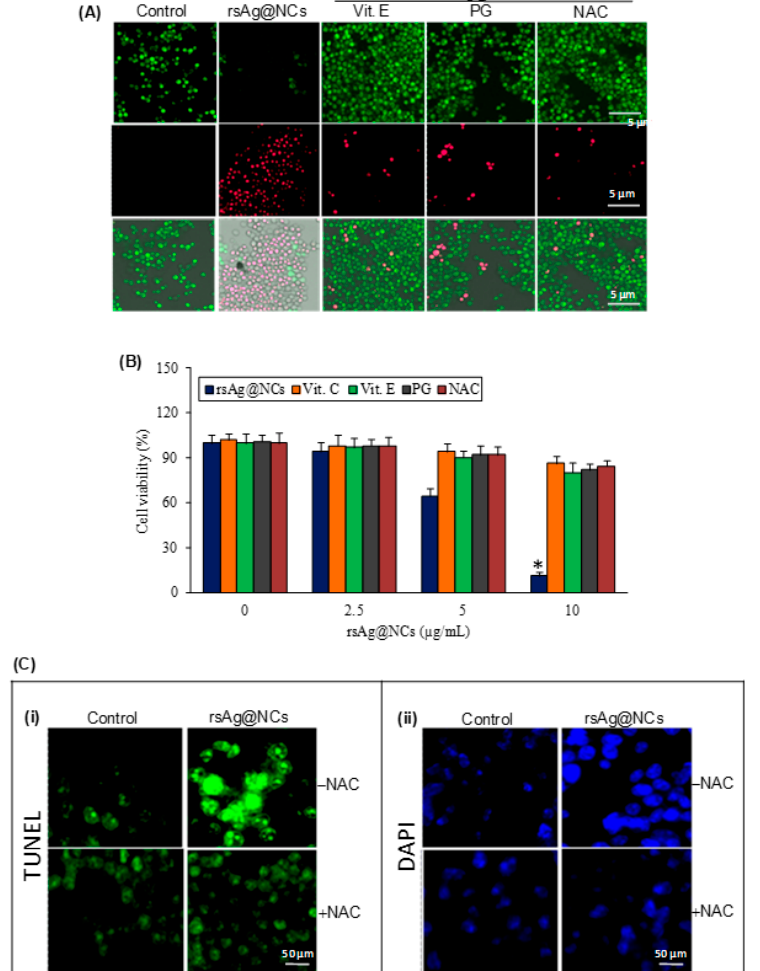
Figure 4. ROS-mediated cell death and apoptosis by rsAg@NCs in FCZ-resistant C. albicans NBC099. ( A ) Cells were treated with rsAg@NCs (10 µ g/mL) and co-cultured with different free radical scavengers, such as L -ascorbic acid α -tocopherol (Vitamin E; 10 µ g/mL), propyl gallate (PG; 10 µ g/mL), and N -acetyl- L -cysteine (NAC; 10 µ g/mL) for 24 h of incubation at 37 ◦ C. Cell viability was determined by using the LIVE/DEAD cell viability kit, following the manufacturer’s protocol (Thermo Fisher). SYTO-9-stained green live cells and PI-stained red cells were analyzed by a Cellinsight CX7 fluorescence microscope. ( B ), Cells were exposed to rsAg@NCs (10 µ g/mL) and ROS scavengers: L -ascorbic acid (Vit C; 10 µ g/mL), α -tocopherol (Vitamin E; 10 µ g/mL), propyl gallate (PG; 10 µ g/mL), and N -acetyl- L -cysteine (NAC; 10 µ g/mL). After 24 h of incubation at 37 ◦ C, cell viability was examined by the 3-(4,5-dimethylthiazol-2-yl)-2,5-diphenyltetrazolium bromide) tetrazolium (MTT) assay. Each reported value represents the mean ± SE from three independent experiments (* p < 0.001, compared with the untreated control). ( C ) Cells were treated with rsAg@NCs (10 µ g/mL) and co-cultured with a ROS scavenger NAC (10 µ g/mL) for 24 h at 37 ◦ C. DNA ends of cells were labelled using (i) the APO BrdU TUNEL Assay Kit, cells were loaded with (ii) DAPI (1 µ g/mL), and eventually, cells were analyzed by fluorescence